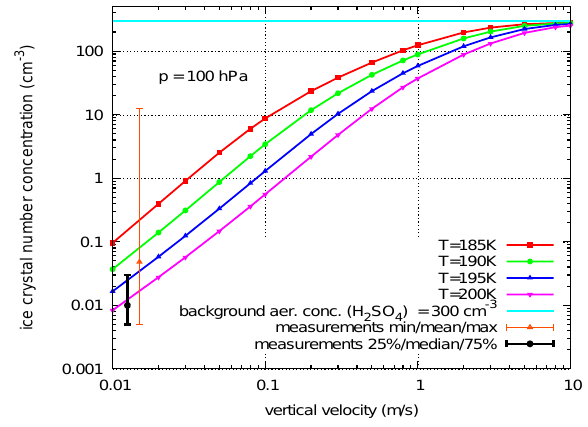
Fig. 2. Ice crystal number concentration as formed in idealized sim- ulations with a prescribed constant updraught under conditions typ- ical for the TTL ( T = 185 / 190 / 195 / 200K – colour code indicated in the inset legend –, p = 100hPa). Note that due to a finite back- ground aerosol concentration, the ice crystal number concentration is limited by the aerosol concentration. This leads to the asymp- totic behaviour of curves for w > 0 . 5ms − 1 . In addition, the mea- sured ice crystal number concentrations are indicated (Krämer et al., 2009); the vertical orange bar indicates minimal and maximal concentrations and the mean value, whereas the vertical black bar indicates the 25 and 75% percentiles as well as the median